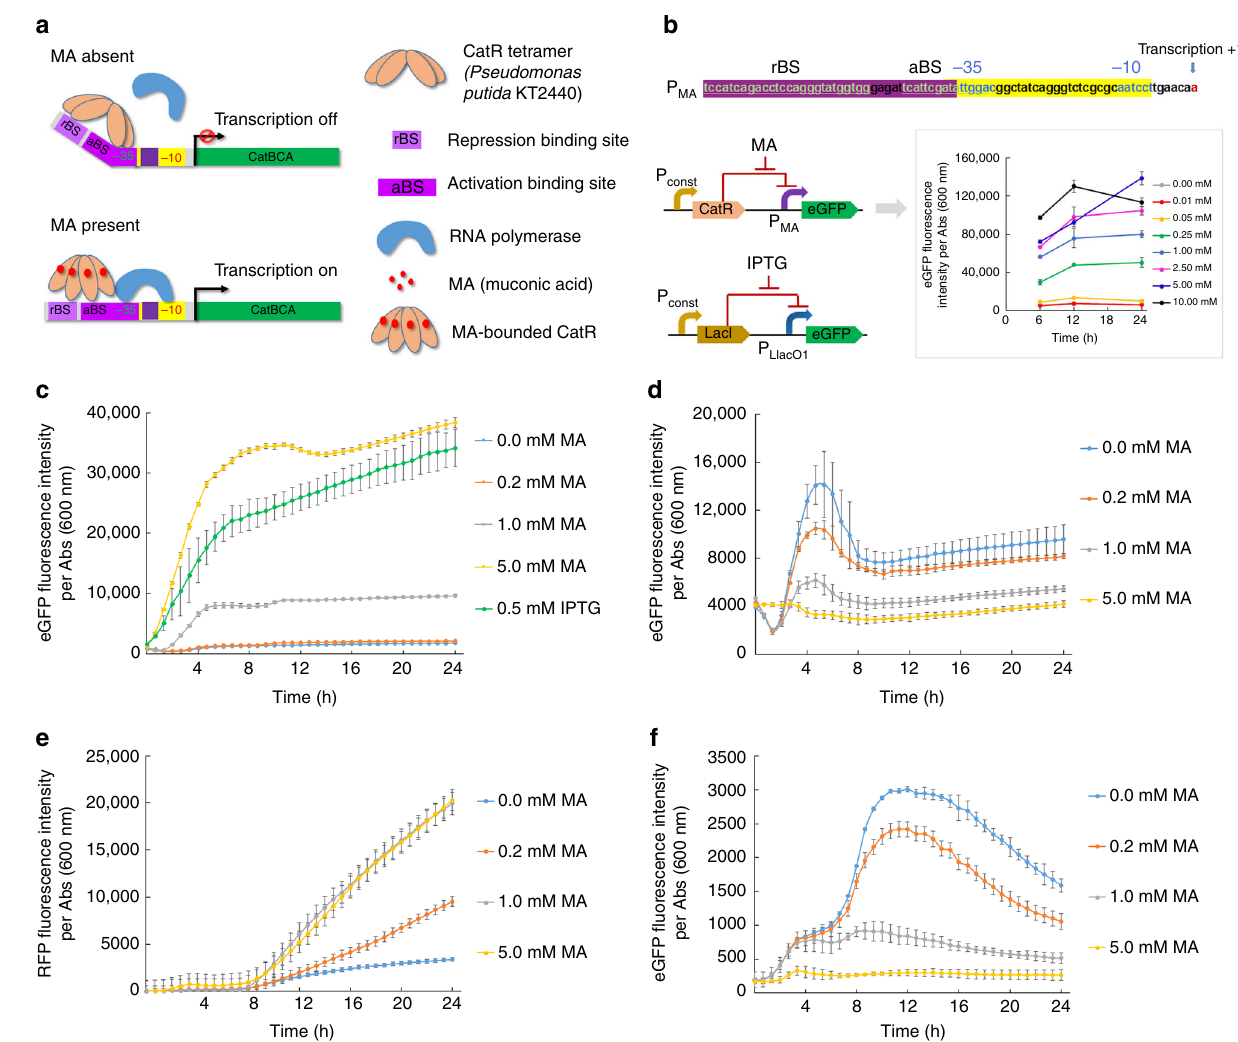
Fig. 1 Characterization of an MA promoter-regulator system through fl uorescence assays. a The schematic diagram of the mechanism of P MA -CatR system. In the absence of MA, the binding of CatR tetramer to the rBS and aBS sequences triggers a DNA bending and blocks the RNA polymerase to recognize the P MA , turning off the transcription of gene catBCA . In the presence of MA, the MA bounded CatR will trigger a conformational change, resulting in relaxing the DNA bending and recruiting the RNA polymerase to turn on the transcription of gene catBCA . b The constructs of fl uorescent reporter system of P MA -eGFP and P LlacO1 -eGFP and the characterization of the P MA promoter with different concentrations of MA through fl uorescence assays. The DNA sequence refers to the P MA promoter. c Time-dependent gene expression dynamics of P MA -eGFP at different concentration (0, 0.2, 1, 5 mM) of MA. Positive control is the P LlacO1 -controlled expression of eGFP induced by 0.5 mM IPTG, (green). d Dynamic downregulation of eGFP expression by RNAi under the control of the MA promoter-regulator. e , f Prototyping sensor-regulator and RNAi-based dynamic control network: e represents the effect of MA-responsive upregulation and f represents the effect of MA-responsive downregulation. The data in b were generated from three biological replicates. All the other data were generated from four biological replicates. The error bars represent